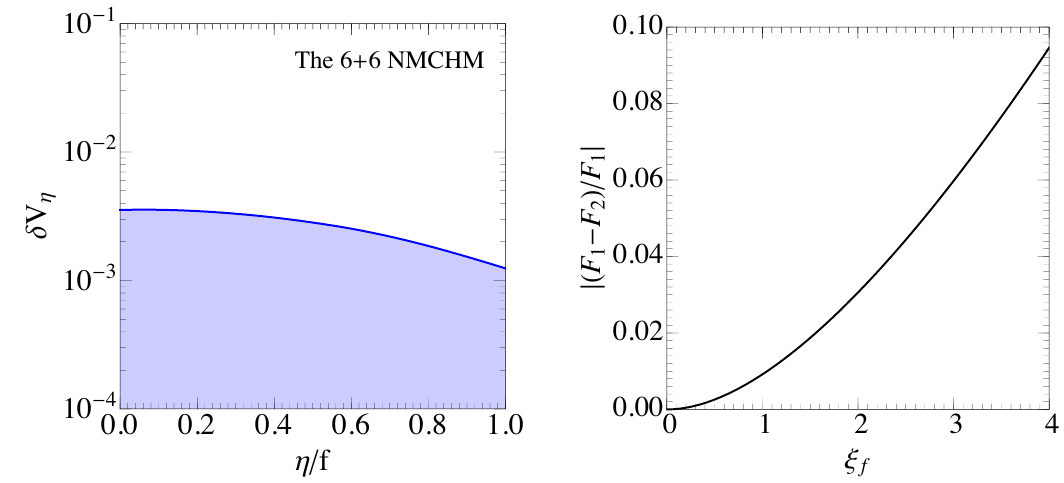
Figure 5 . Left: the relative di(cid:11)erence between potentials calculated by the complete Coleman- Weinberg integral and the polynomial expansion. Right: the relative di(cid:11)erence of F 1 and F 2